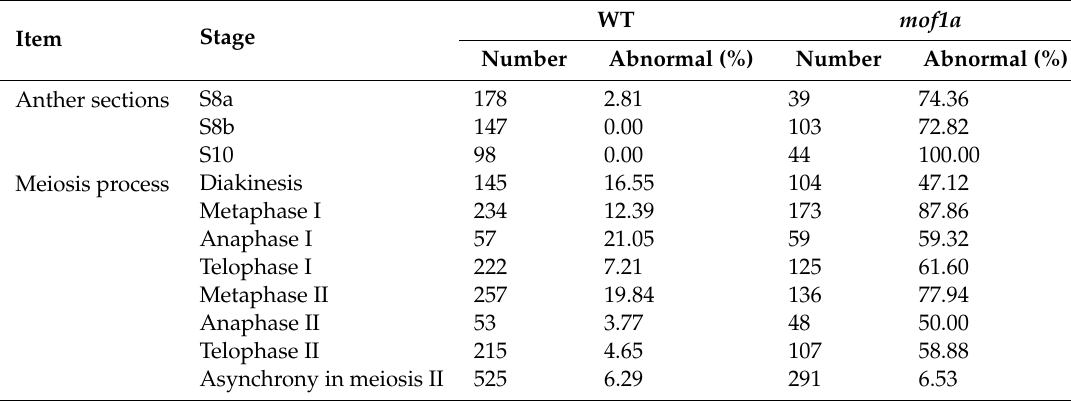
Table 2. Frequency of pollen mother cells with abnormal anther chambers or abnormal chromosome behavior during meiosis in WT (H1) and